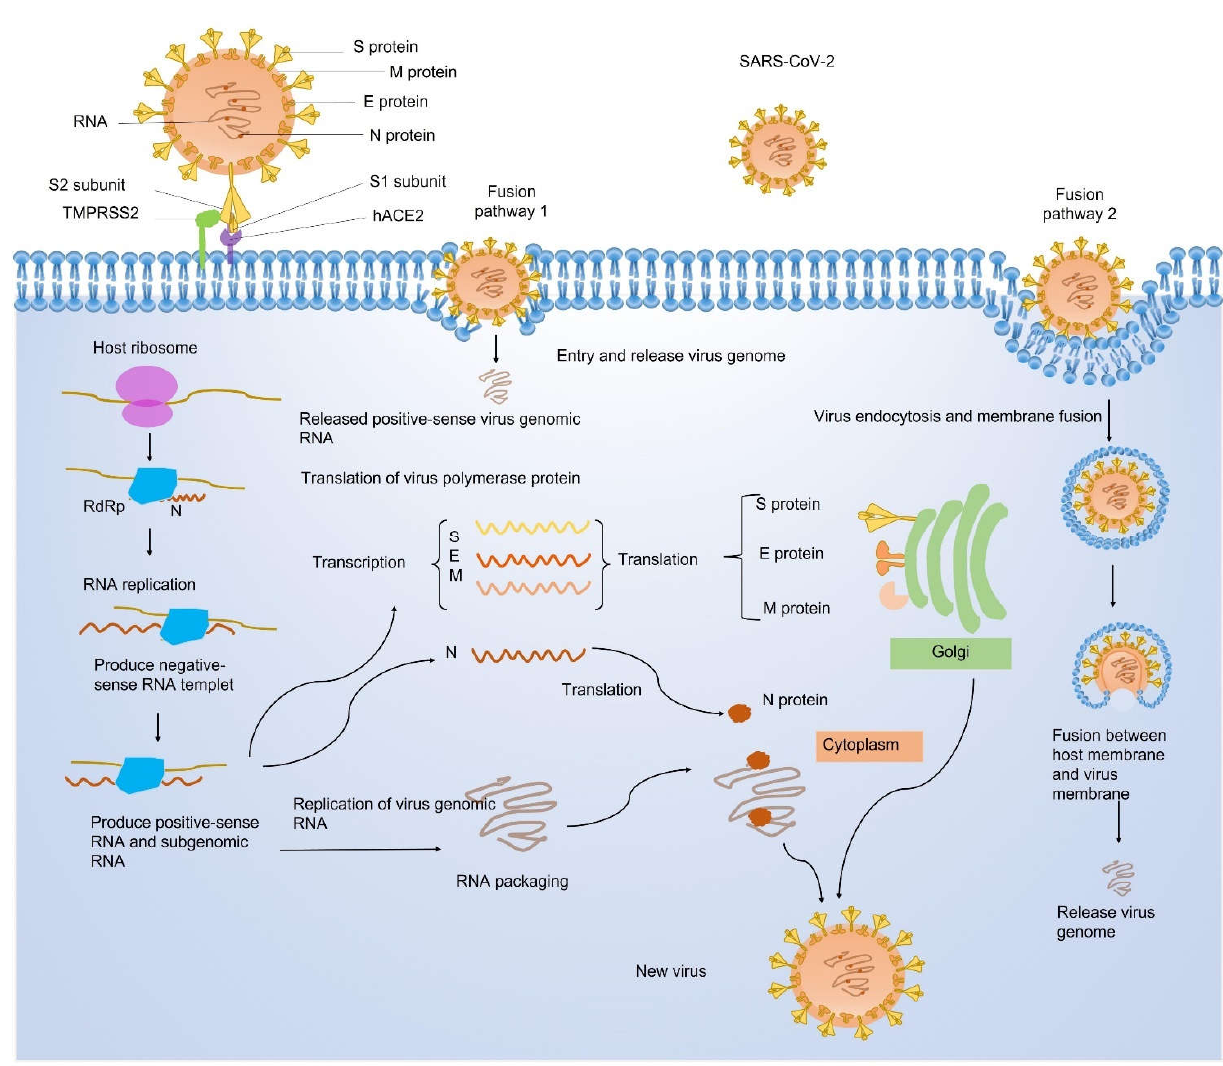
Figure 2. The binding, entry, and package of SARS-CoV-2 in host cells. Genome-encoding proteins are labeled on an enlarged virus. There are two fusion pathways of viral protein with the host cell membrane, including (1) direct fusion with the cell membrane to release the virtual genome RNA and (2) endocytosis via membrane fusion of the viral membrane with a host cell membrane. hACE2: human angiotensin-converting enzyme 2; M: membrane protein; N: nucleocapsid protein; RdRp: RNA-dependent RNA polymerase; SARS-CoV-2: severe acute respiratory syndrome coronavirus-2; S: Spike protein; TMPRSS2: transmembrane serine protease 2.